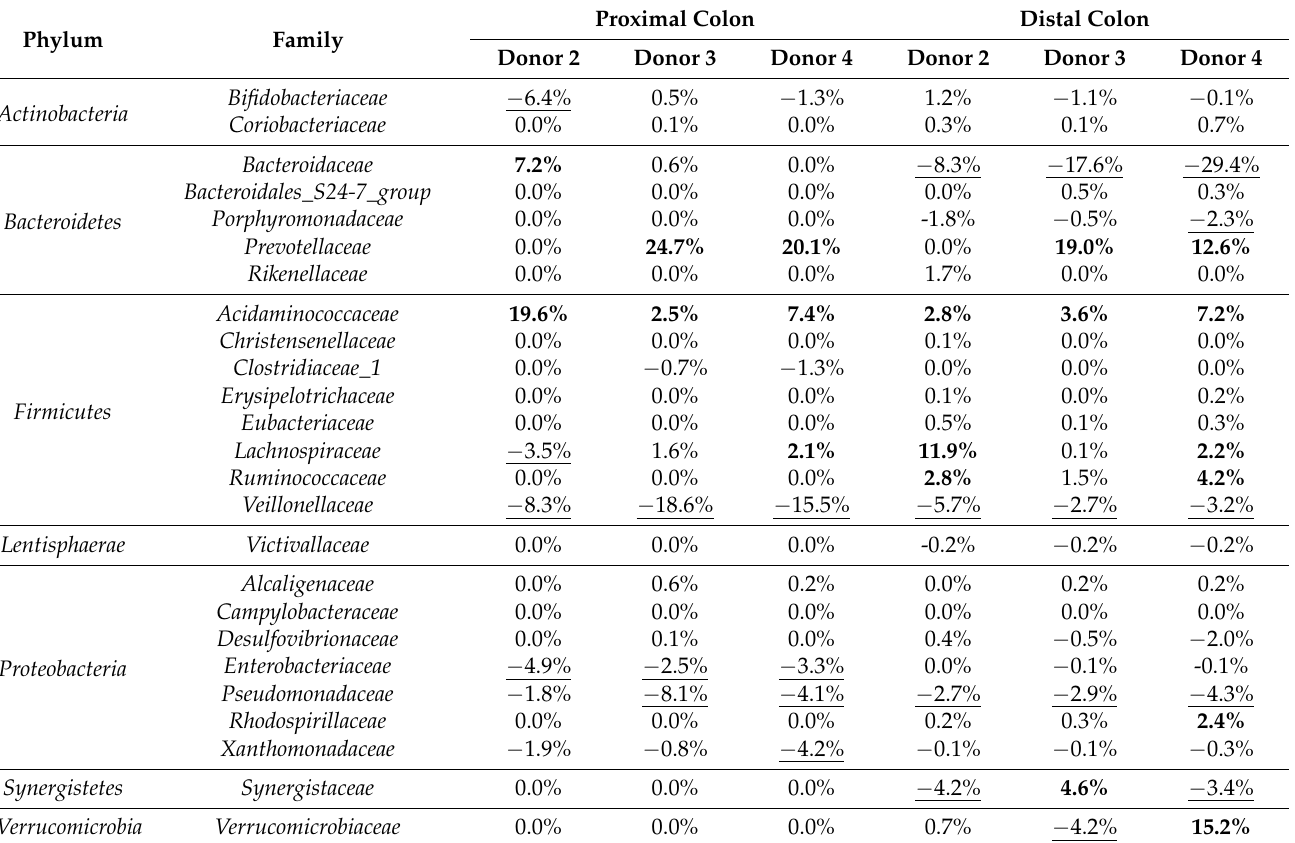
Table 2. Effect of FCP on microbial composition (families belonging to specific phyla) in the lumen (as estimated via 16S rRNA gene profiling (%)) of the simulated proximal and distal colon of the triple-M-SHIME. The data is presented as the difference between the value obtained at the end of the treatment period (TR: Day 35) and the end of the control period (C: Day 14) ( n = 1). An increase (indicated in bold when > 2%) thus reflects a stimulation of a given family by repeated FCP treatment, while a decrease (indicated by underlining when < − 2%) suggests a decrease due to FCP